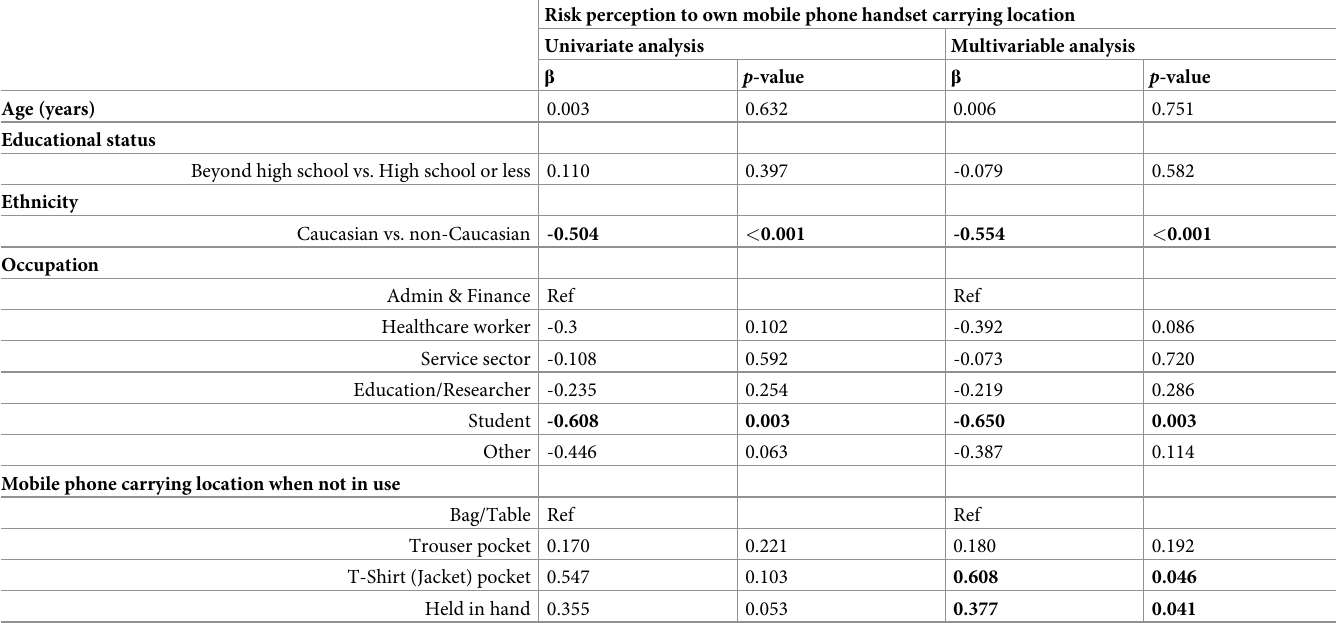
Table 2. Linear regression models for selected predictor variables and risk perception to own mobile phone carrying